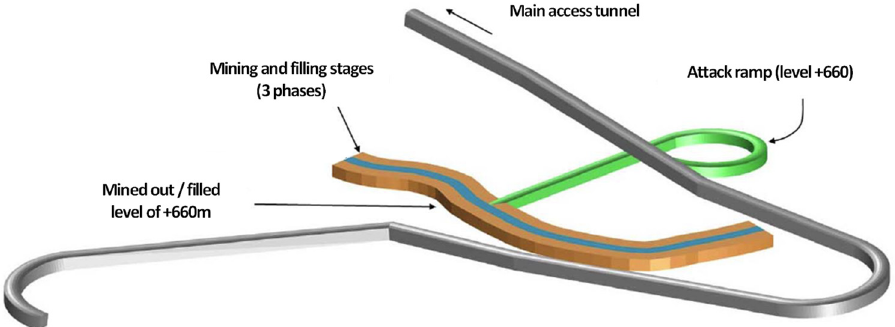
Figure 3. Development of the cut-and-fill mining scheme at the +660 m level [9].